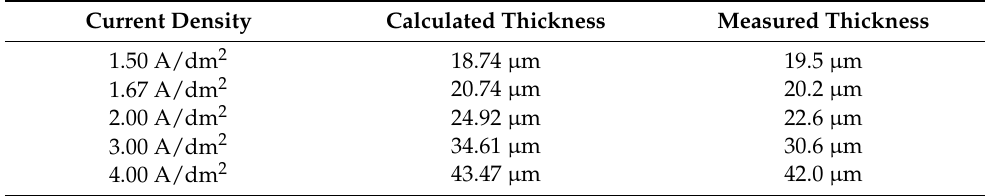
Table 2. Calculated and measured film thickness with different current density.